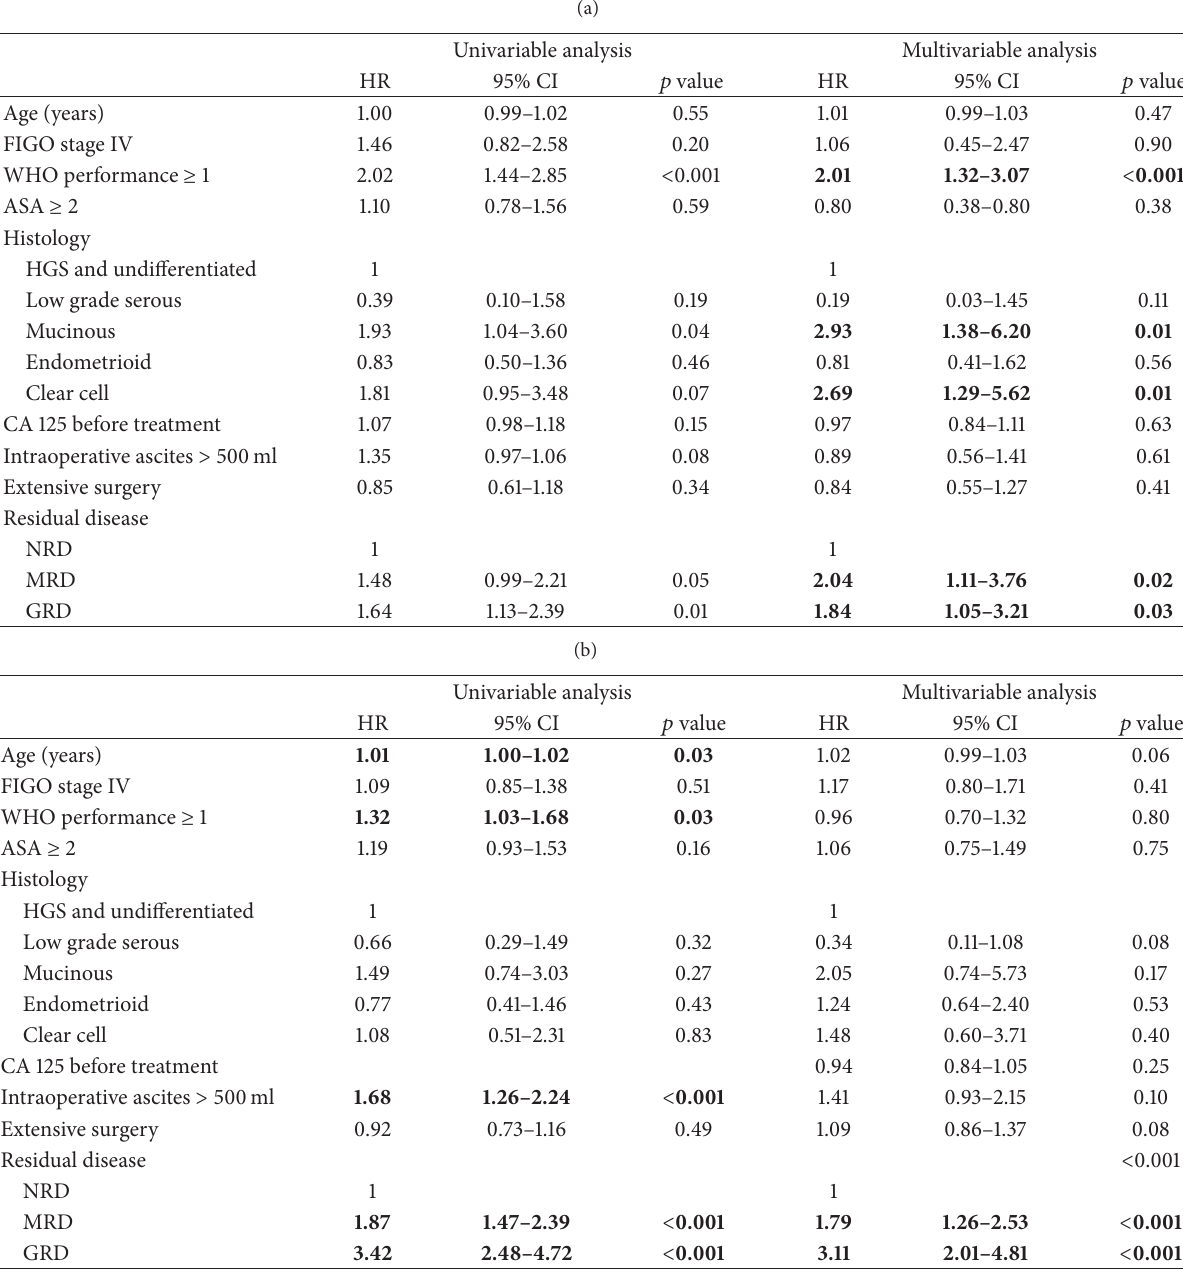
Table 4: Prognostic factors for disease specific survival after primary debulking surgery (a) and after interval debulking surgery